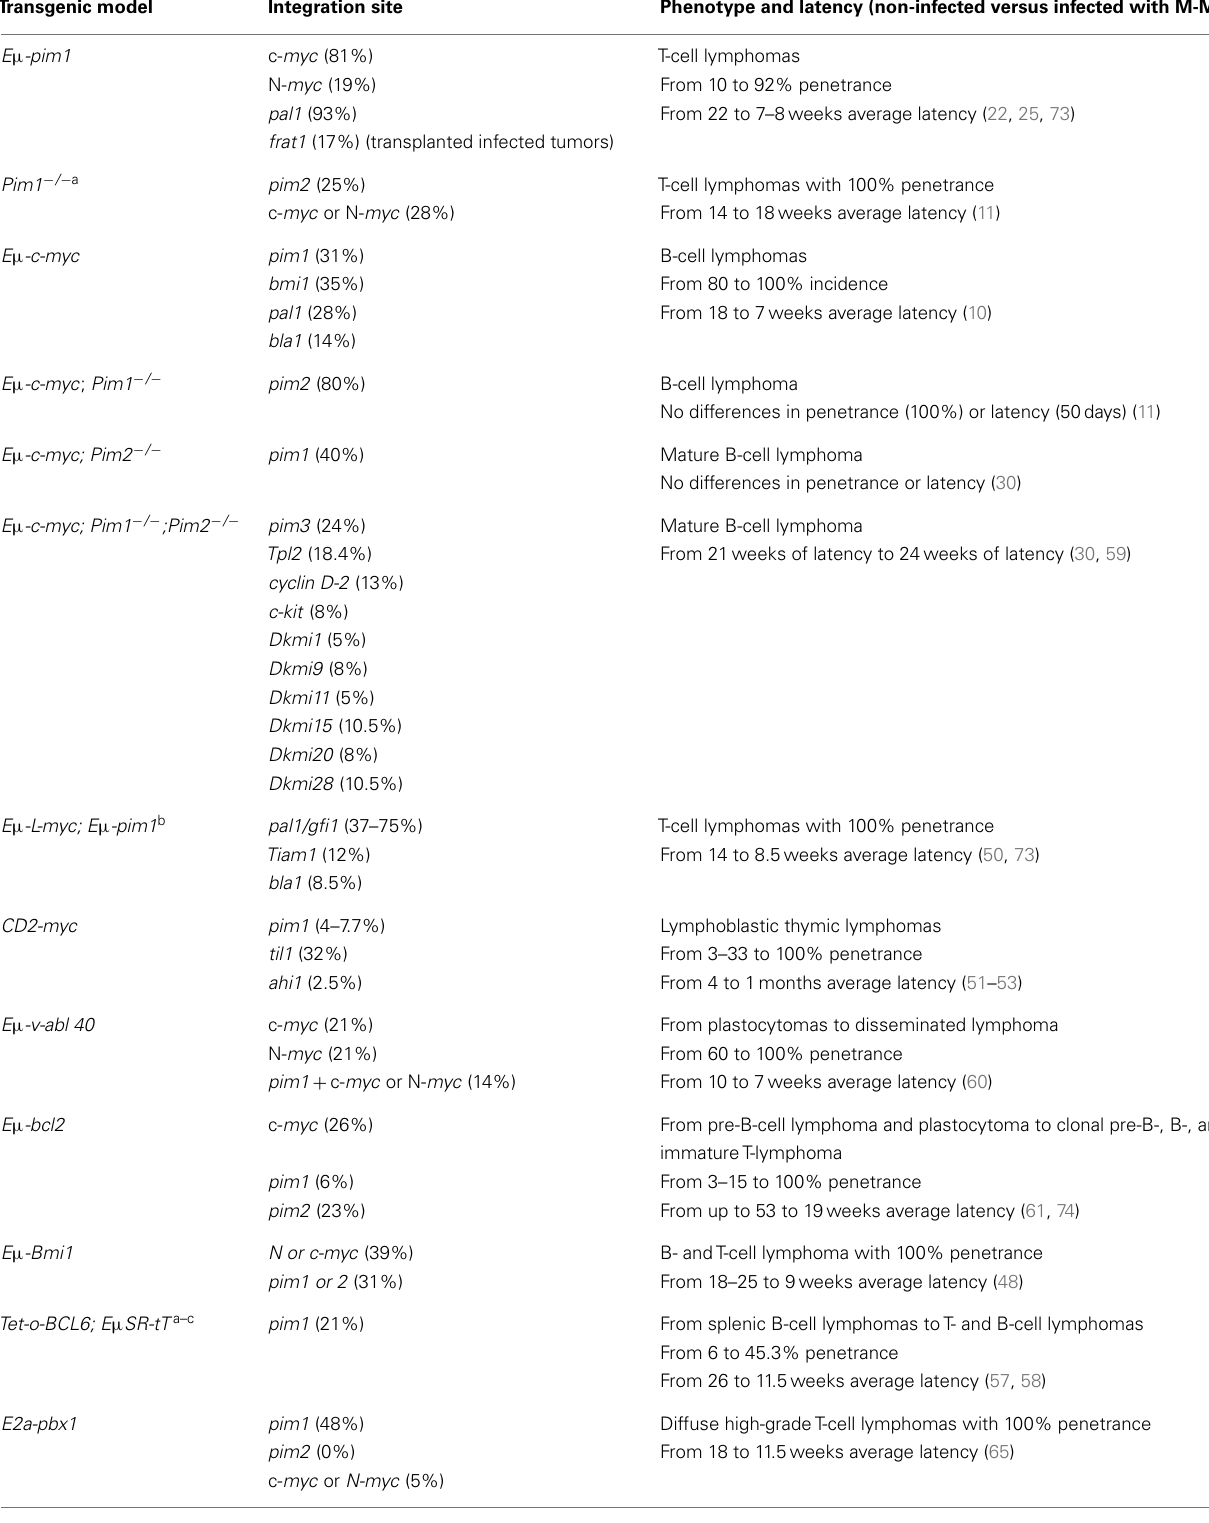
Table 4 | Proviral integration in the pim loci and cooperating oncogenes after M-MuLV infection of transgenic mice . Transgenic